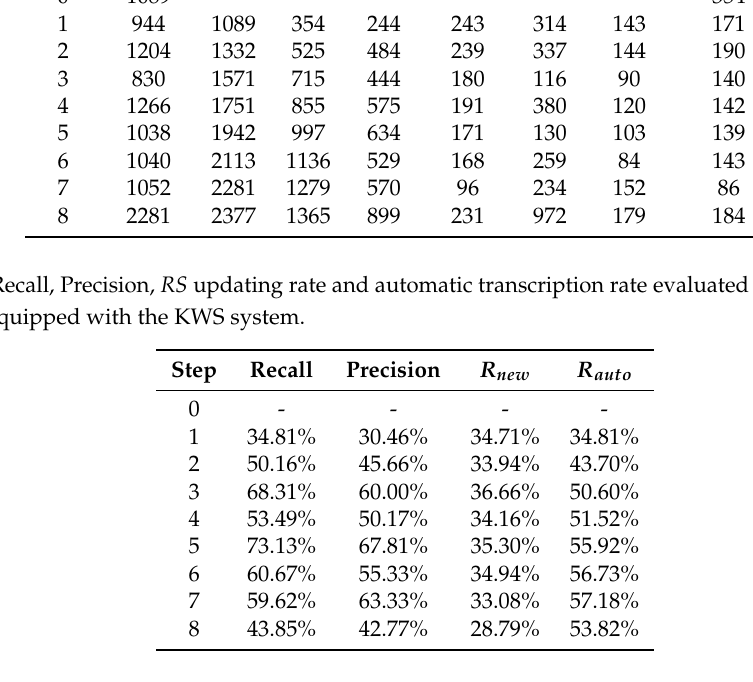
Table 5. Transcription time with the baseline system and the multi-step procedure, time gain, step by